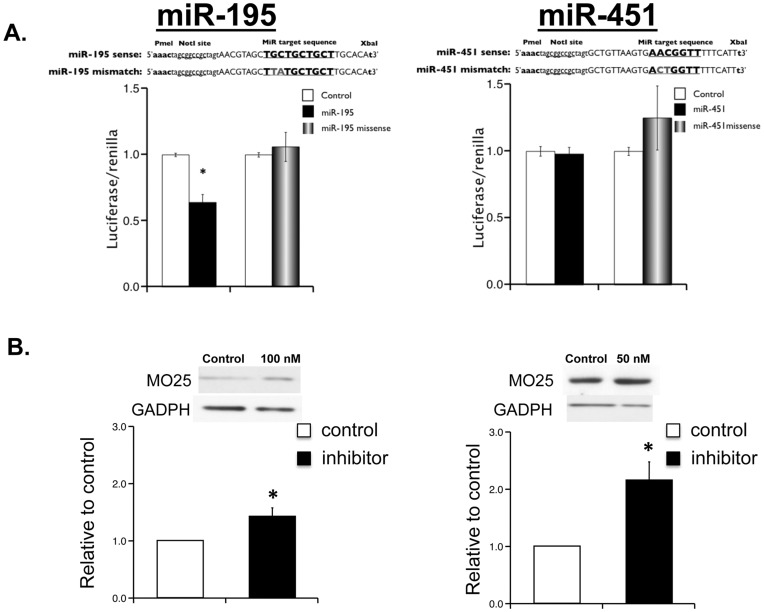
MO25 is a functional target of miR-195 and miR-451.
A: C2C12 cells transfected with luciferase constructs. MO25 3′ UTR target sequences (as indicated) of miR-195 (left panel) or miR-451 (right panel). Bar graph representation of luciferase expression in C2C12 cells treated with miR-195 (left panel) or miR-451 (right panel) mimics or negative siRNA control. Each bar indicates mean values ± S.E.M. of 3 separate experiments. *P<0.05 compared to WT group. B: Increase in expression of MO25 in C2C12 cell by miScript miRNA inhibitor delivered using HiPerfect reagent. AllStars Negative Control siRNA was used as negative control. Each bar indicates mean values ± S.E.M. of 3 separate experiments. *P<0.05 compared to WT group.